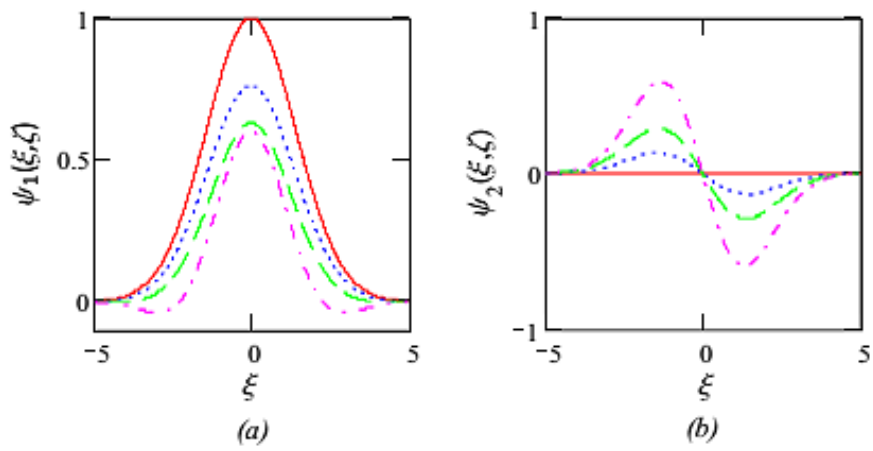
Figure 1. ζ -evolution of the two components ( a ) ψ for the input given by Equation (66), shown at ζ = 0 (red solid line), ζ = 0 . 3 (blue dotted line), ζ = 0 . 6 (green dashed line), and ζ = 1 (magenta dash-dotted